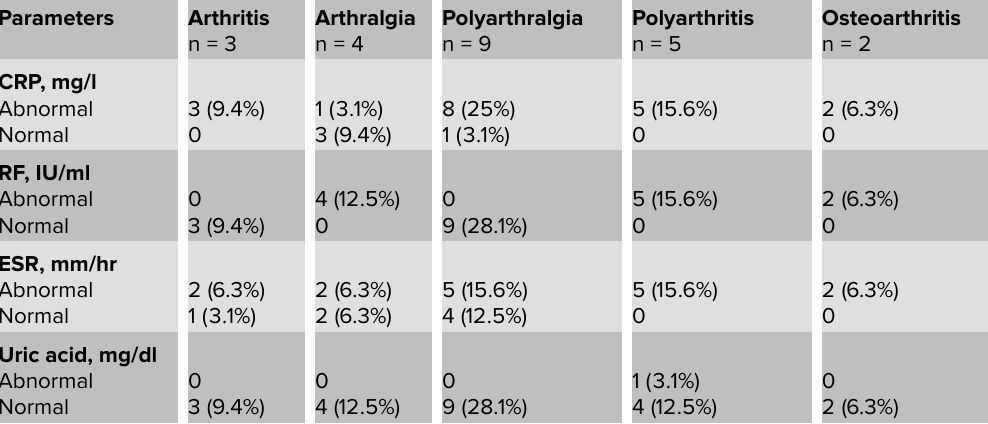
TABLE 3: Laboratory findings with rheumatologic conditions in the study